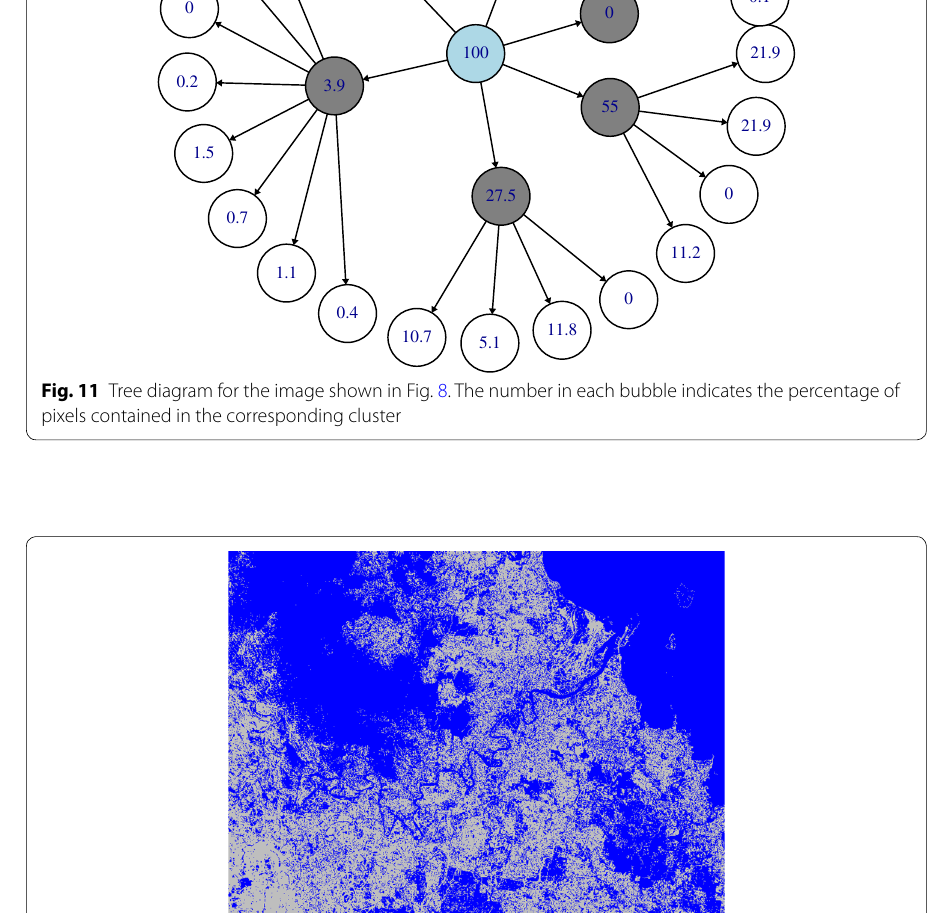
Fig. 12 Classification of image from 2010 using OCSVM. The preferred habitat of fire-ant is shown in gray